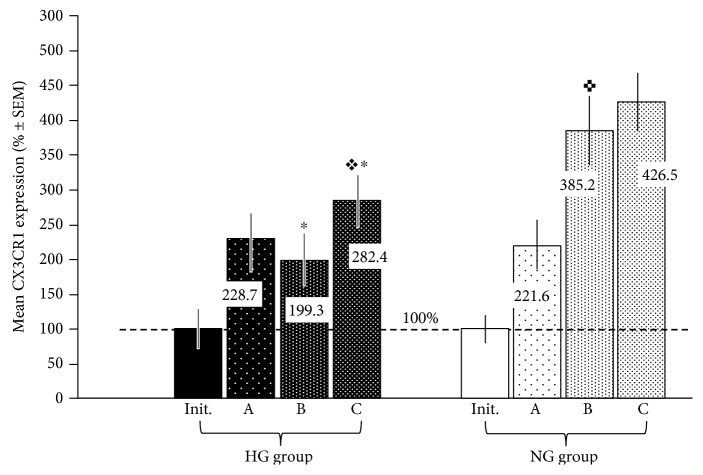
Effect of resveratrol administration on CX3CR1 expression. Resveratrol was given in three different doses (10, 50, and 100 μM) in the respective subgroups (A, B, and C), and the mean placental expressions of CX3CR1 in perfused human placental tissue under hyperglycemic (glucose 25 mmol/L; HG group) and normoglycemic (glucose 5 mmol/L; NG group) conditions have been analysed. The mean value of CX3CR1 expression in the specimens obtained at the end of the adaptive period (before the administration of LPS; see Figure 2.) was treated as the initial (init.) and taken as 100% in each group. ∗ indicates p < 0.05 (HG group versus NG group); ✜ indicates p < 0.05 (HG subgroup C versus NG subgroup B); ✚ indicates p < 0.05 (NG subgroup B versus NG subgroup A).